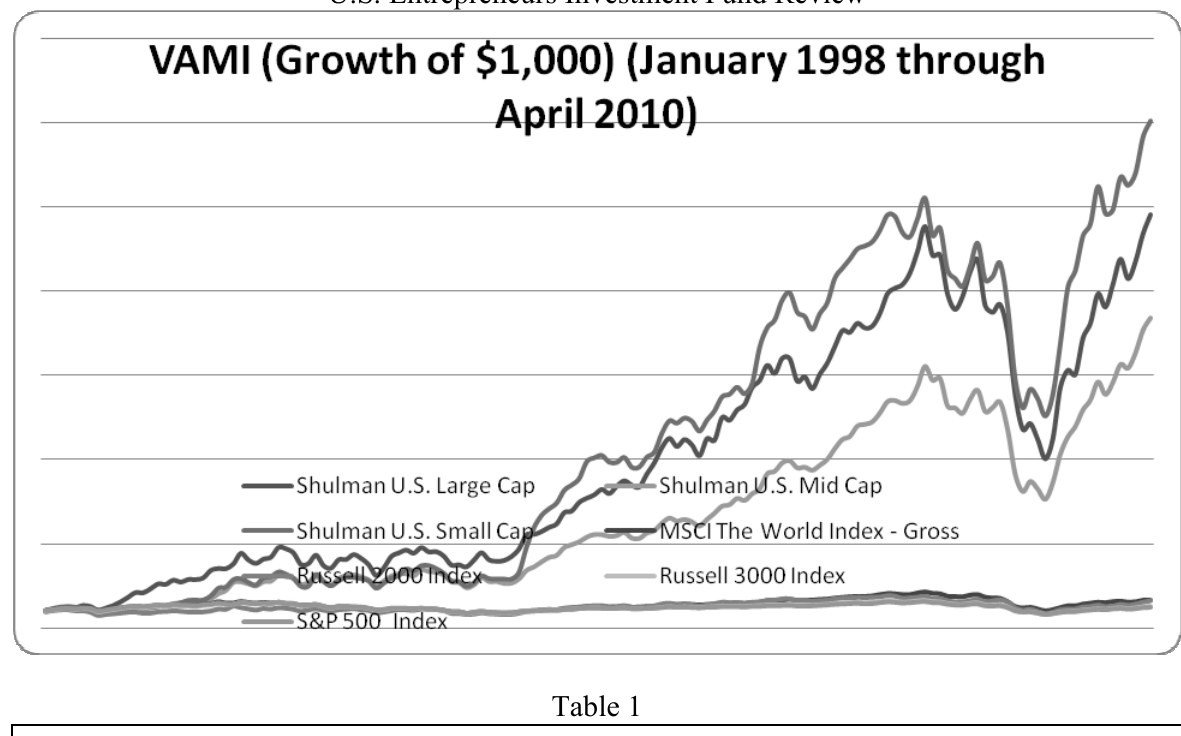
Trailing Periods – Percentage Rate of Return (January-1998 through April-2010)